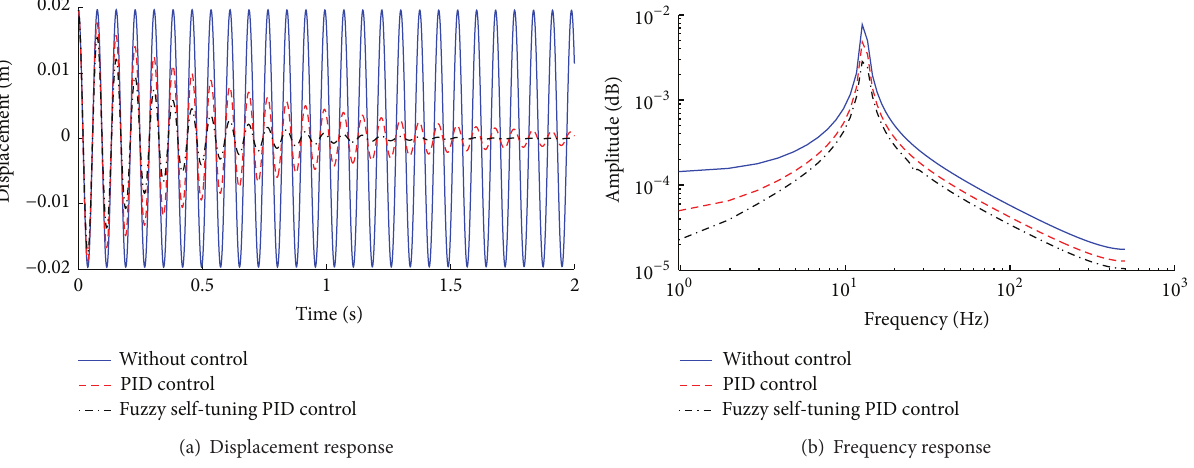
Figure 5: The midpoint response with and without control in initial displacement field.